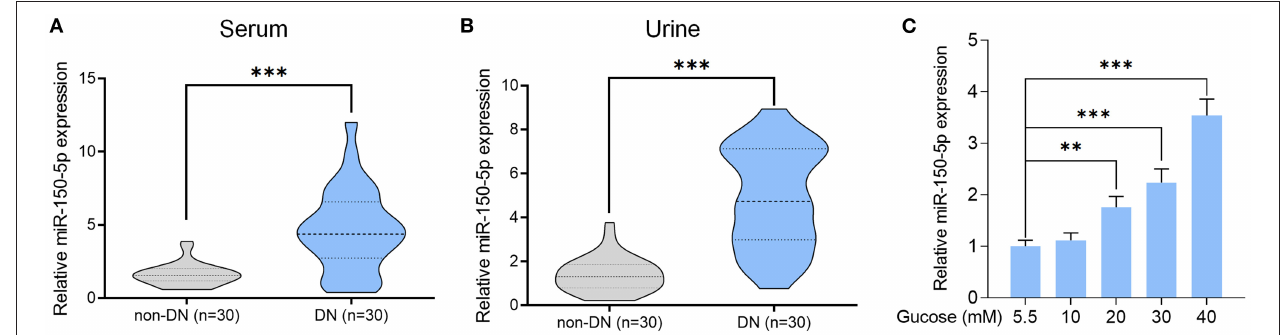
FIGURE 1 | High glucose increased the level of miR-150-5p in the serum and urine of patients with diabetic nephropathy as well as in podocytes. (A,B) The level of miR-150-5p in the serum and urine of diabetic nephropathy (DN) patients was determined using quantitative real-time PCR (qRT-PCR). (C) The level of miR-150-5p in podocytes cultured in different concentrations of glucose was determined using qRT-PCR ( n = 3). Data are expressed as mean ± SEM (** p < 0.01, *** p <